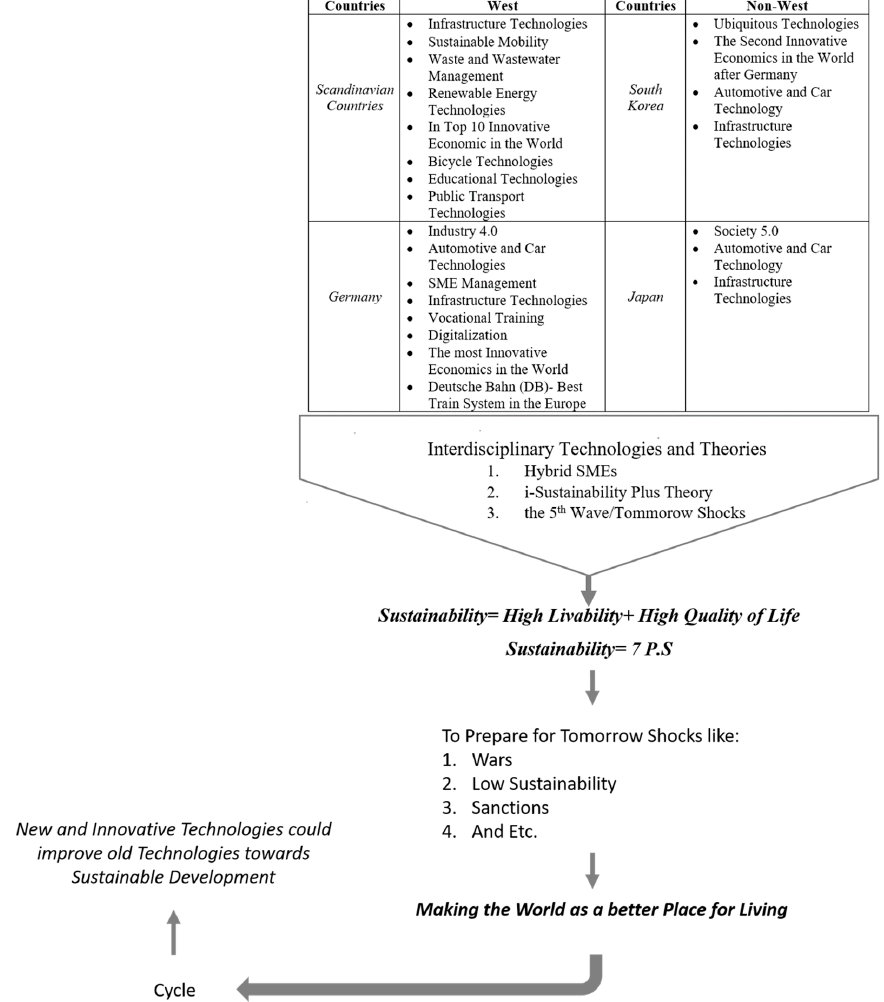
Figure 7. Western and Non-Western Blue-Green Mobility Technologies.